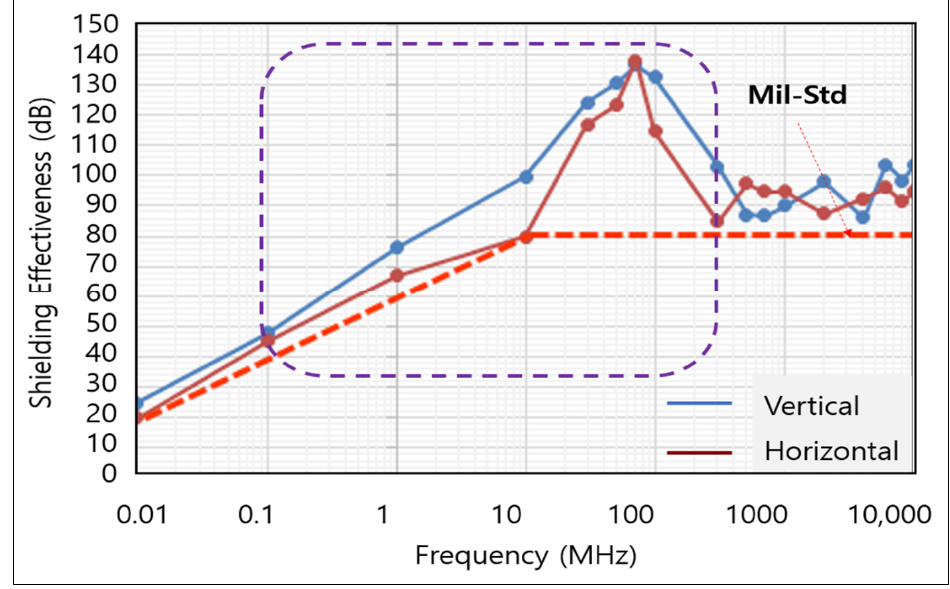
Figure 10. Shielding effectiveness of specimen #7 (W = 1000).